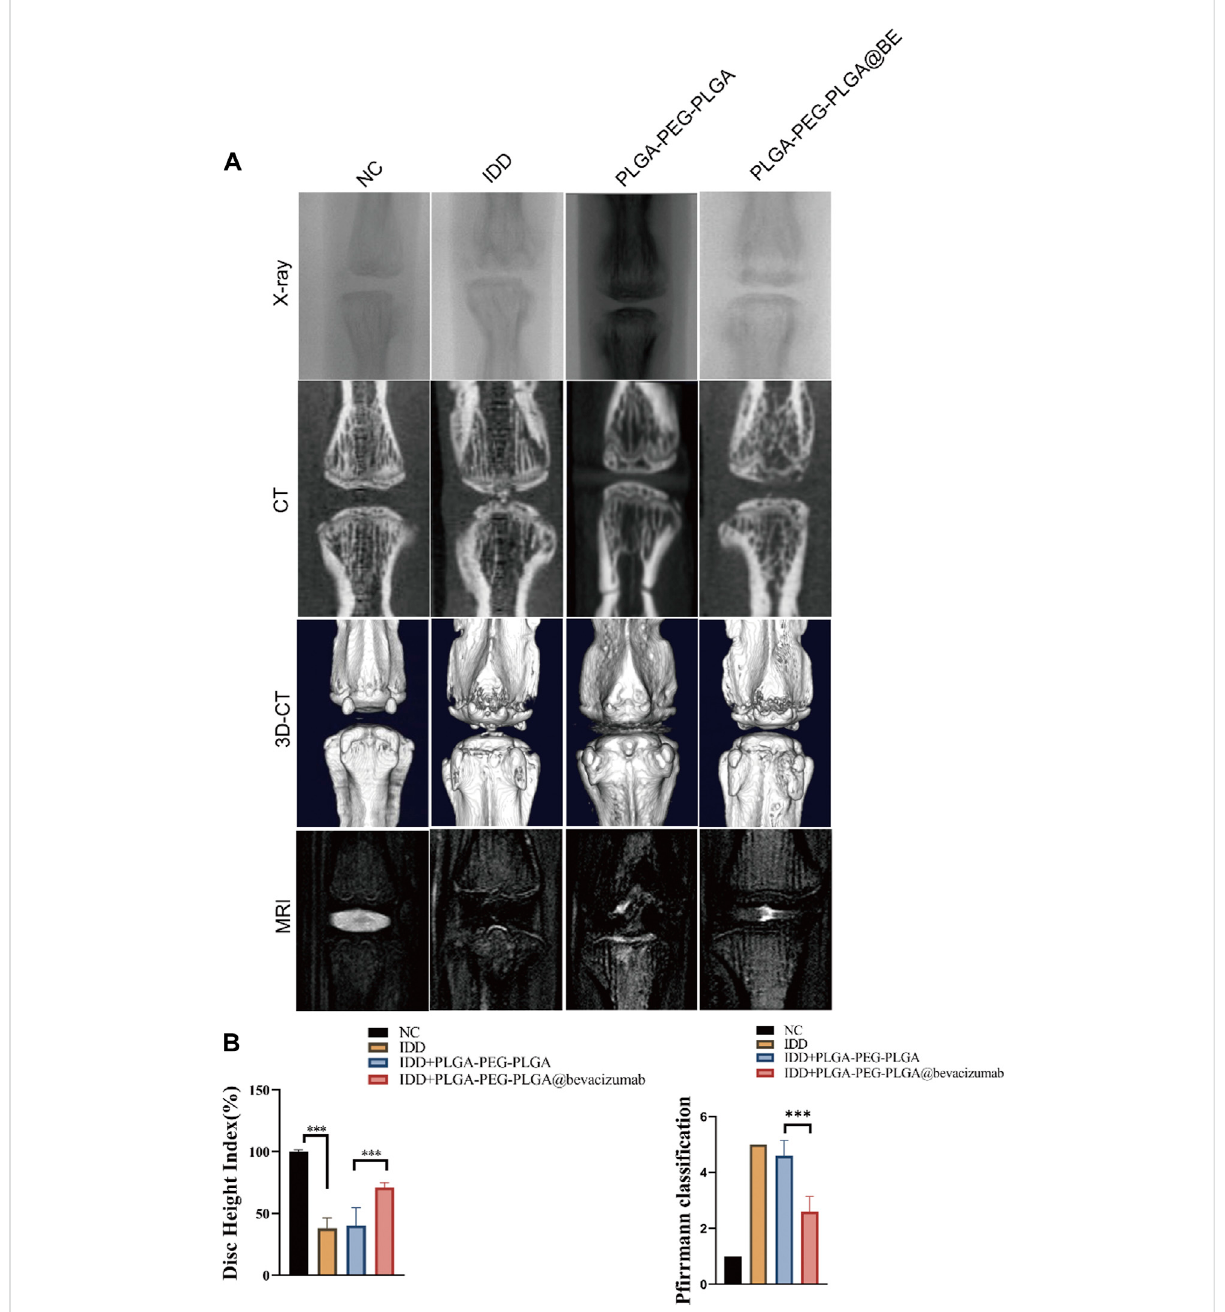
FIGURE 4 Radiological data of animal experiments by imaging system. (A) Representative X-ray, CT and MRI images of the rat ’ s caudal vertebrae at 8 weeks. (B) ThechangeofDHI%in4groupsat8 weeks.(C)MRIgradingchangesineachgroupat8 weeks.dataareexpressedasmean±SD(n=5). * p < 0.05; *** p <